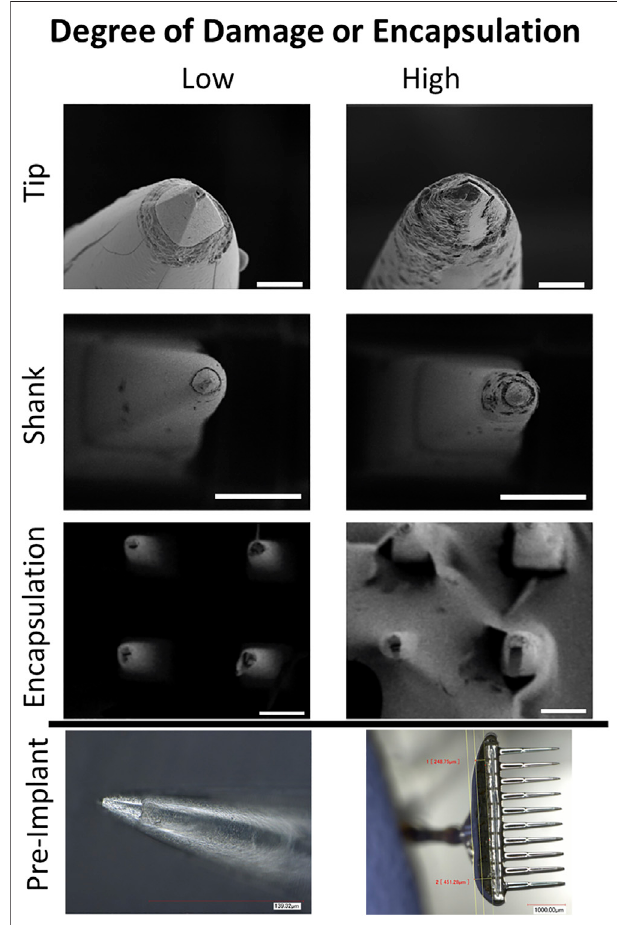
FIGURE 5 | Tip and shank damage occurred on some implanted electrodes and encapsulation occurred on four implanted arrays. Representative high magni fi cation images of undamaged/unencapsulated and damaged/encapsulated electrodes. Tip images were taken from P1 array 1, with the degraded tip showing demetallation and biologic fouling (scale bar is 10 µm). Shank images were taken from P2 lateral stimulating array (scale bar is 100 µm). The degraded shank shows multiple surface and subsurface irregularities including pitting and delamination from the tip. Encapsulation images were from P2 medial stimulating array (scale bar is 100 µm). Pre implant optical images are provided to display pristine